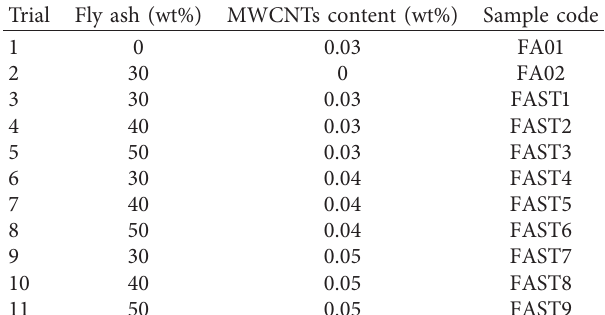
Table 2: Taguchi orthogonal array of designed experiments based on the coded